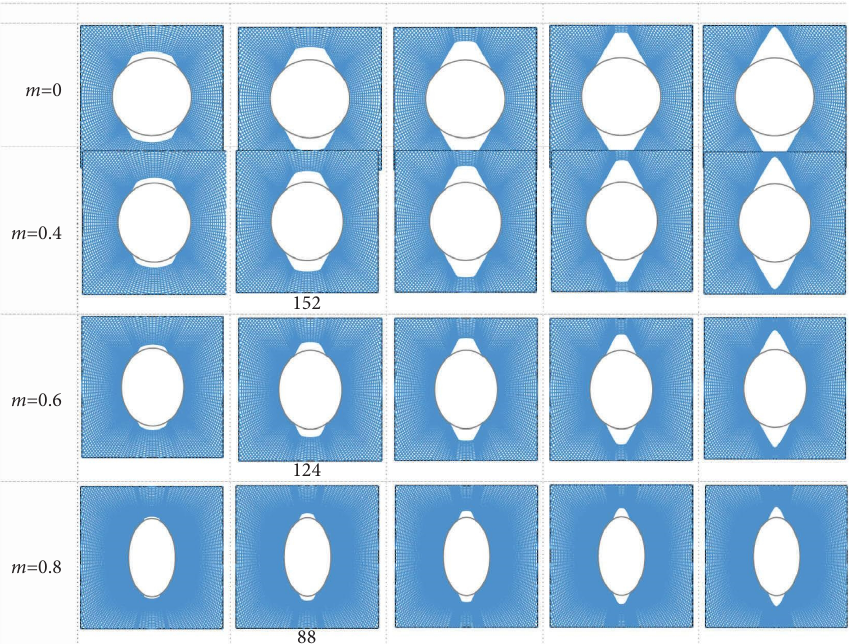
Figure 10: Episodic breakout progression for holes with diferent eccentricities; the last column shows the fnal shape of the